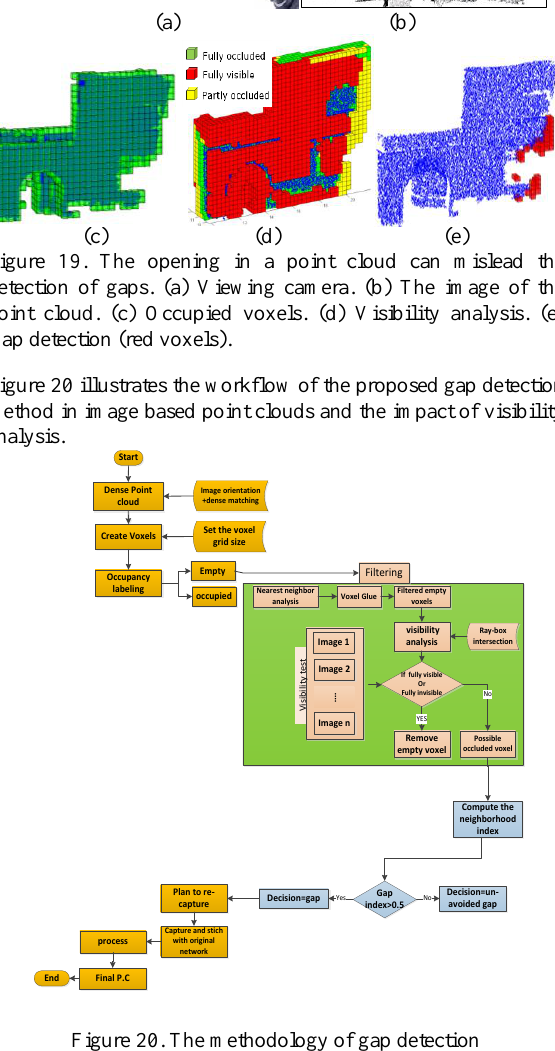
Figure 18. (a) Proximity measure. (b) 3*3 neighboring voxels